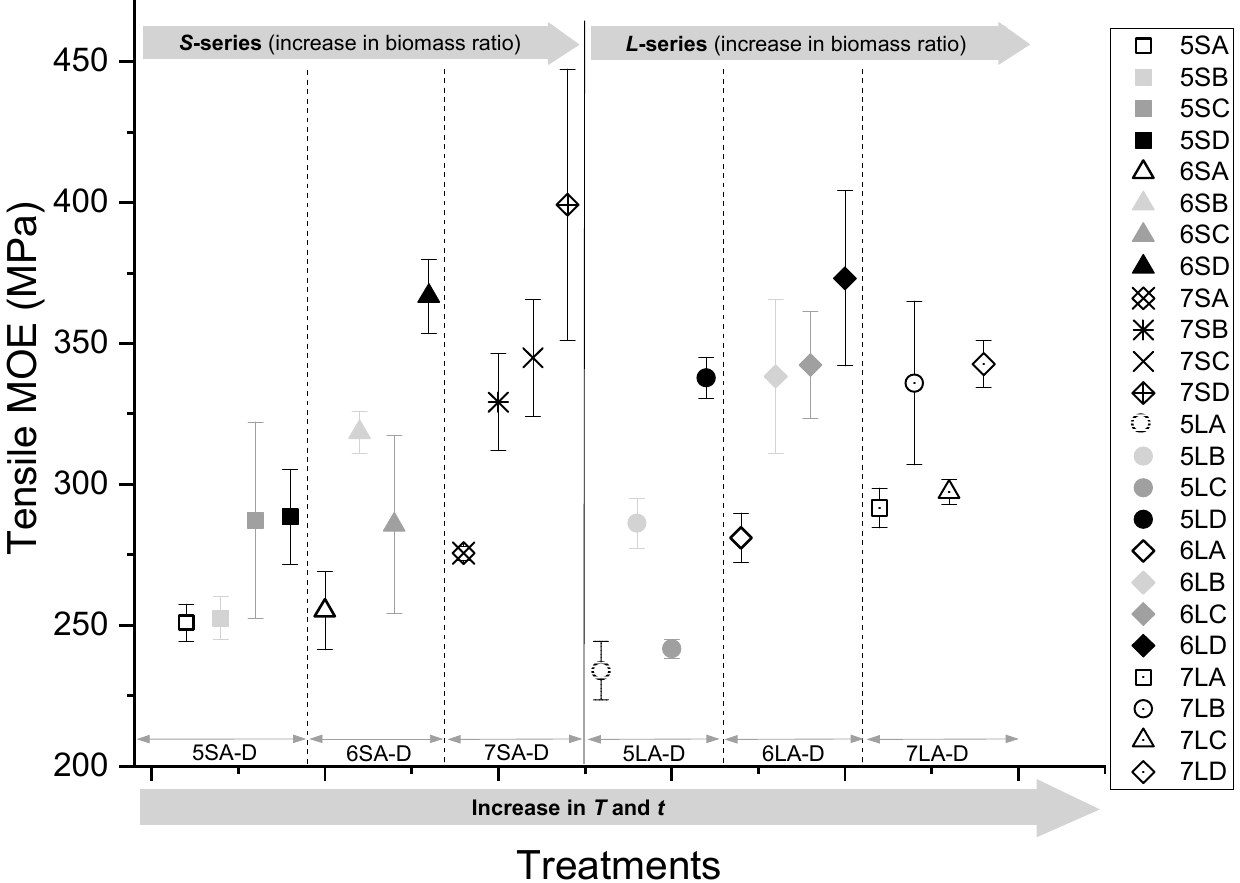
Figure 13. Tensile MOE of the WPCs pressed at different temperatures and times (A-D) with 50, 60, and 70% biomass at two particle sizes (S and L).